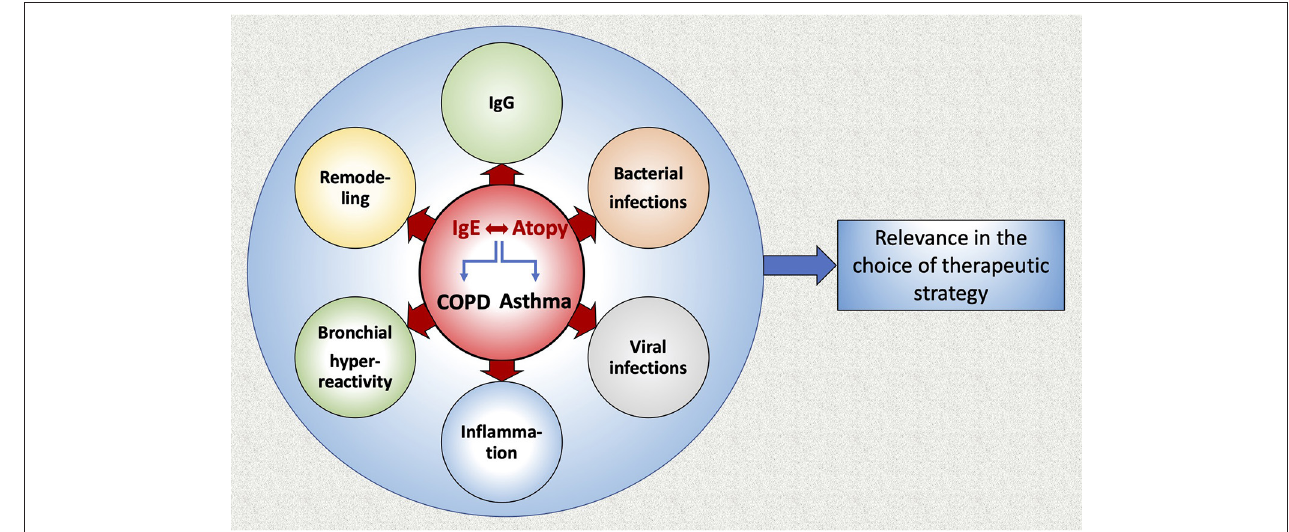
FIGURE 3 | Graphic abstract of the